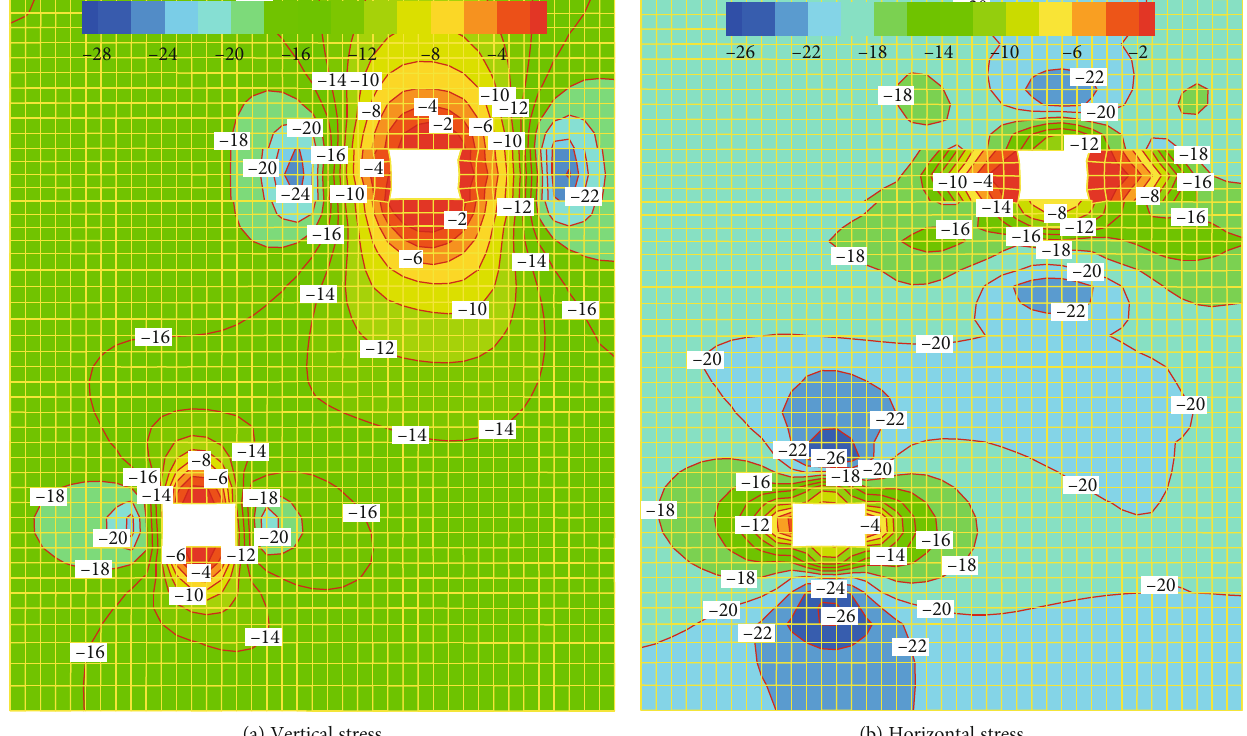
Figure 11: Distribution law of stress fi eld in surrounding rock of roadway after excavation.